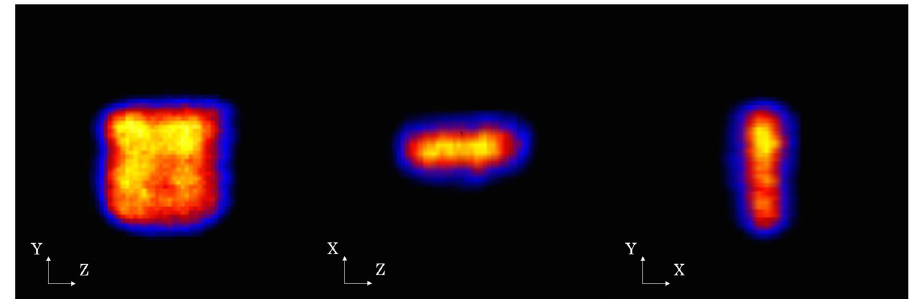
Figure 3. 2-D slices of the 3-D imaging result at the center. ( Left ) in the Z-Y plane, ( center ) in the Z-X plane, and ( right ) in the X-Y plane.